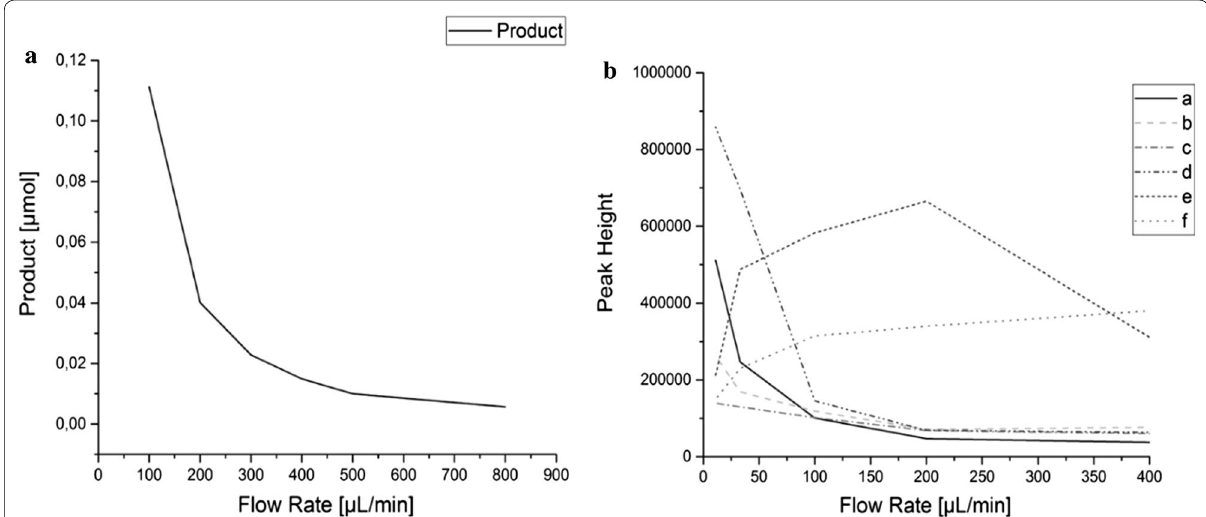
Fig. 5 Flow rate dependent product formation. a Flow rate dependent formation of nitrophenol by converting the Boc- l -alanine-4-nitrophenyl ester, b flow rate dependent formation of peptide peaks